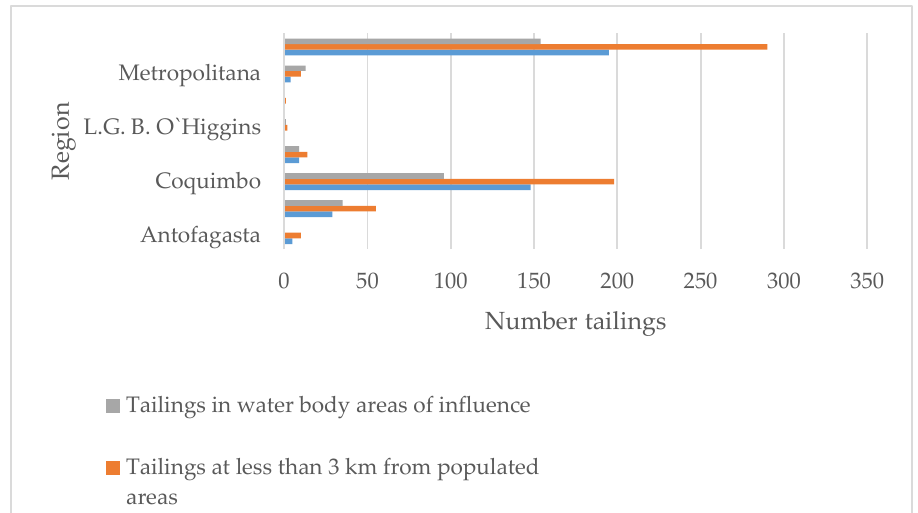
Figure 5. Distribution of tailings at less than 2–3 km from populates areas; tailings located close to water bodies (rivers, lakes, and estuaries).